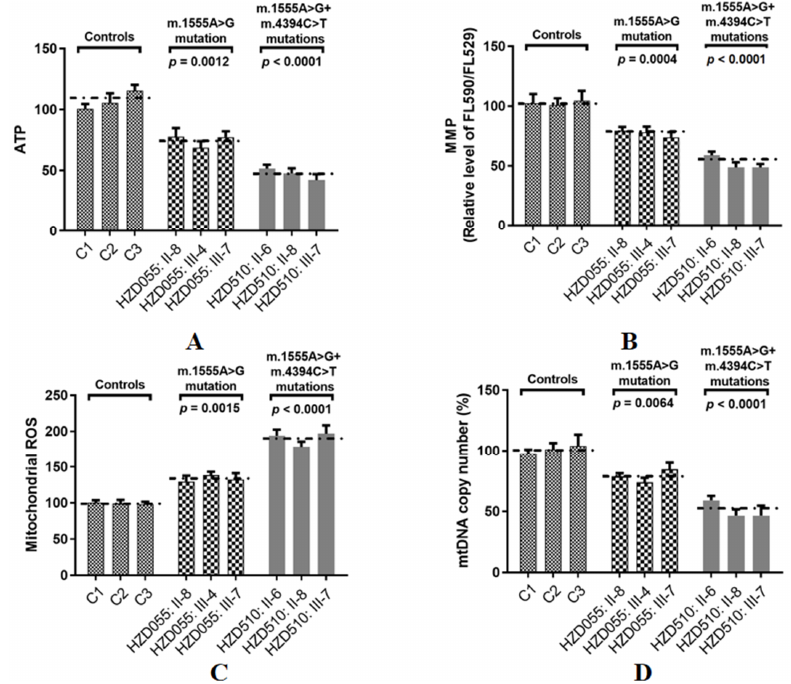
Figure 7. Assessments of mitochondrial functions in three patients with both the m.1555A>G and m.4394C>T mutations, three patients with only the m.1555A>G mutation and three controls. ( A ) Analysis of ATP production in nine cybrids; ( B ) MMP analysis in cybrids; ( C ) Qualification of ROS levels; ( D ) Determining the mtDNA